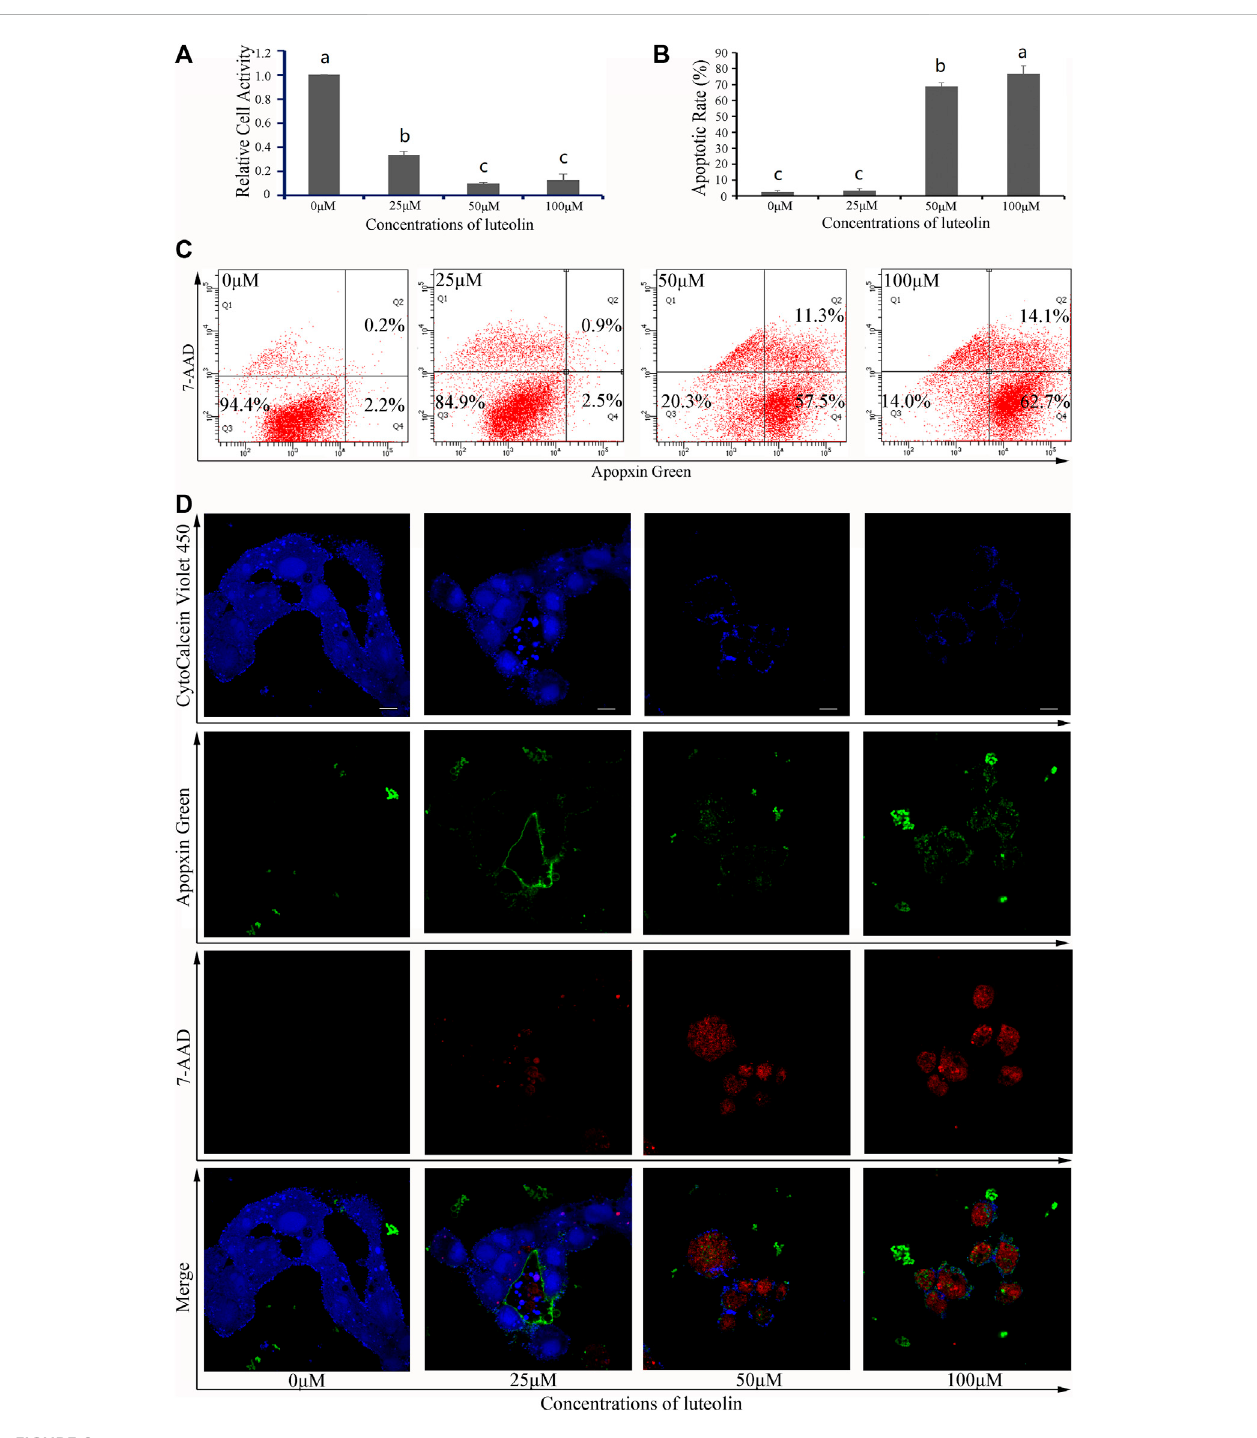
FIGURE 8 EffectsofluteolinonHepG2cells. (A) Relativecellactivity; (B) Apoptoticrate.Dataareexpressedasthemean±SEM( n =3).Differentsmalllettersindicate extremely signi fi cant differences between two treatments ( p < 0.01). (C) Representative FACS plots of cells treated with different concentrations of CTFs and stained with Apopxin Green and 7-AAD to identify apoptotic cells in the early and late stages, respectively. From left to right, the concentration of CTFs was 0 μ M,25 μ M,50 μ M,and100 μ M.Dataarerepresentativeoffourindependentexperiments. (D) RepresentativeCLSMimagesofHepG2cellstreatedwith different concentrations of CTFs and stained with CytoCalcein Violet 450 (in blue color, representing live cells), Apopxin Green (in green color), 7-AAD (in red color). Representative CLSM images of apoptotic HepG2 cells treated with different concentrations of CTFs, CytoCalcein Violet 450 (in blue color, representinglivecells),ApopxinGreen(ingreencolor),7-AAD(inredcolor)andallofthree fl